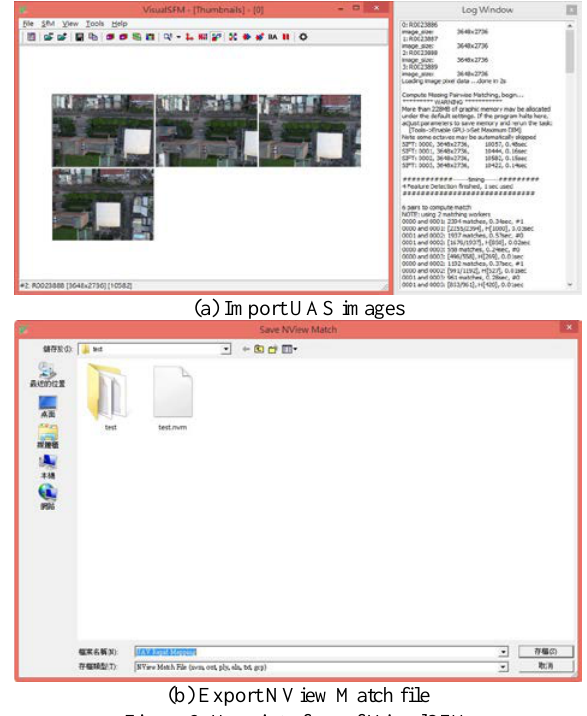
Figure 2. User interface of